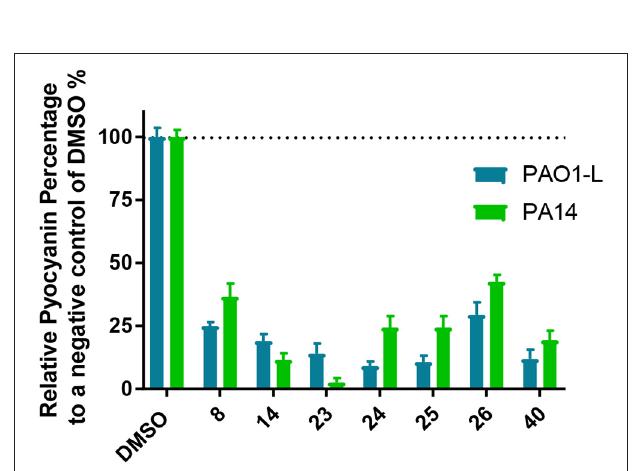
FIGURE 3 | X-ray crystal structure of PqsR in complex with compound 40 and M64 (PDB:6B8A) (Kitao et al., 2018) (A) X-ray co-crystal structure of 40 bound to PqsR LBD. The protein structure is presented in gray and residues Tyr 258 and Leu 207 are labeled in black. (B) Overlapping crystal structures of 40 and M64 in complex with PqsR ligand binding domain. Compound 40 is represented in yellow and M64 in light blue.